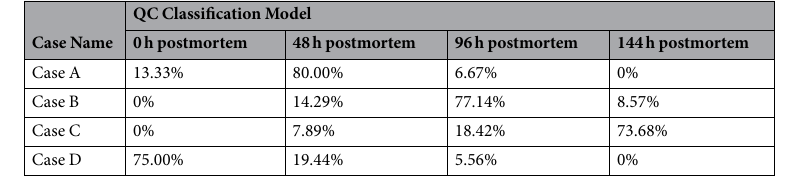
Table 8. Real routine applications of the complete QC classification